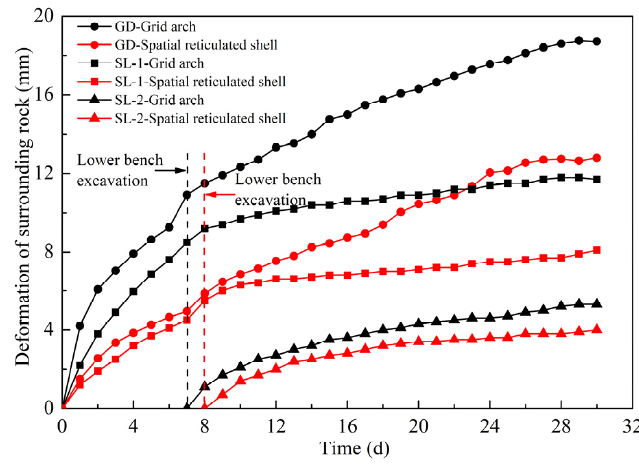
Figure 25. Duration curves of the displacement of the surrounding rock.